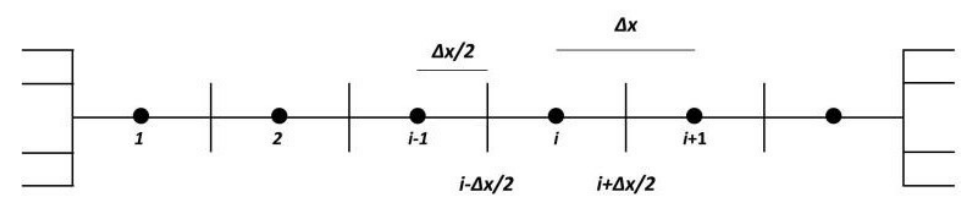
Figure 2. Node and face generation in a uniform discretization of finite volume method.